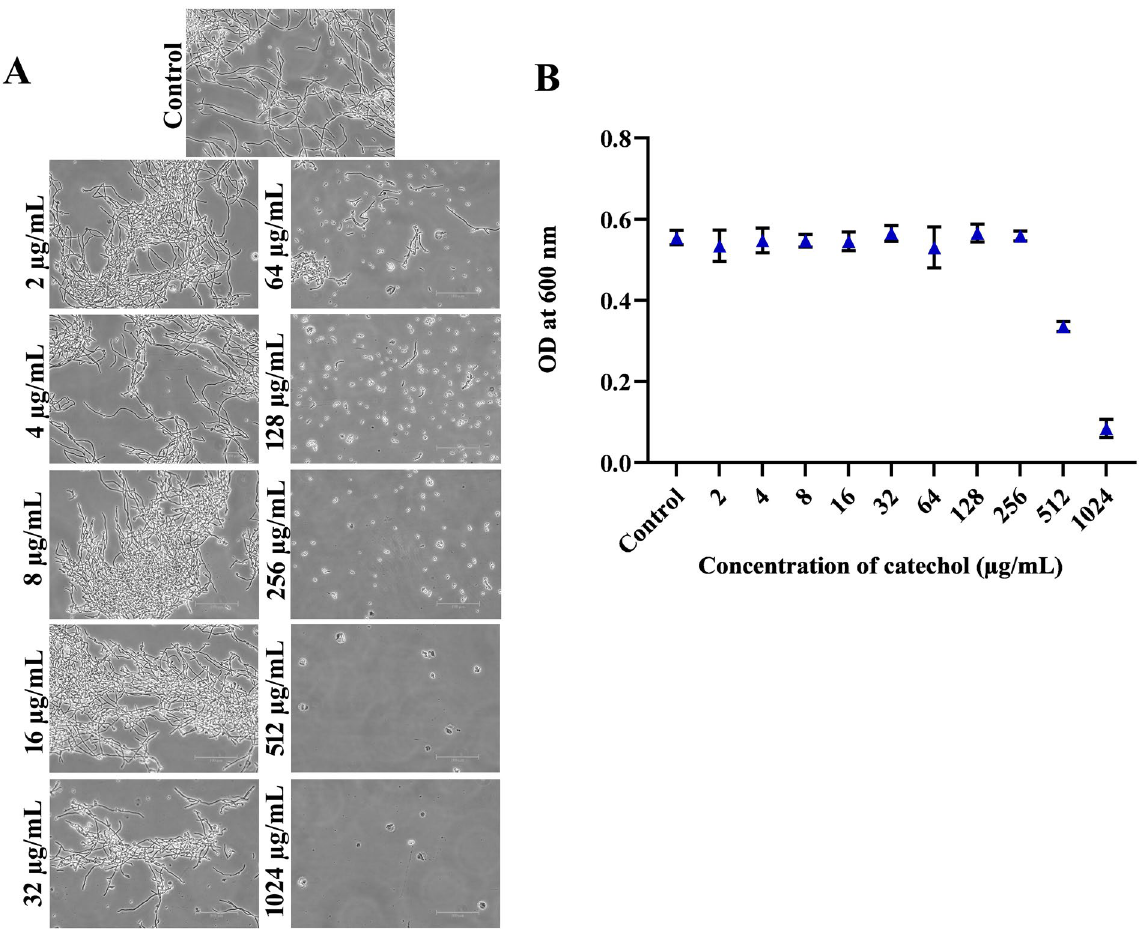
Figure 2. Effect of catechol on yeast to hyphae transition and planktonic growth. ( A ) C. albicans was grown on liquid spider medium with and without catechol. After 24 h incubation, test samples were photographed under phase contrast microscope. Micrograph of control group exposed very dense and lengthy filamentous cells, catechol treated groups exposed a more number of evenly distributed yeast cells. ( B ) Impact of catechol at various concentrations on C. albicans planktonic growth in spider broth after 24 h incubation.